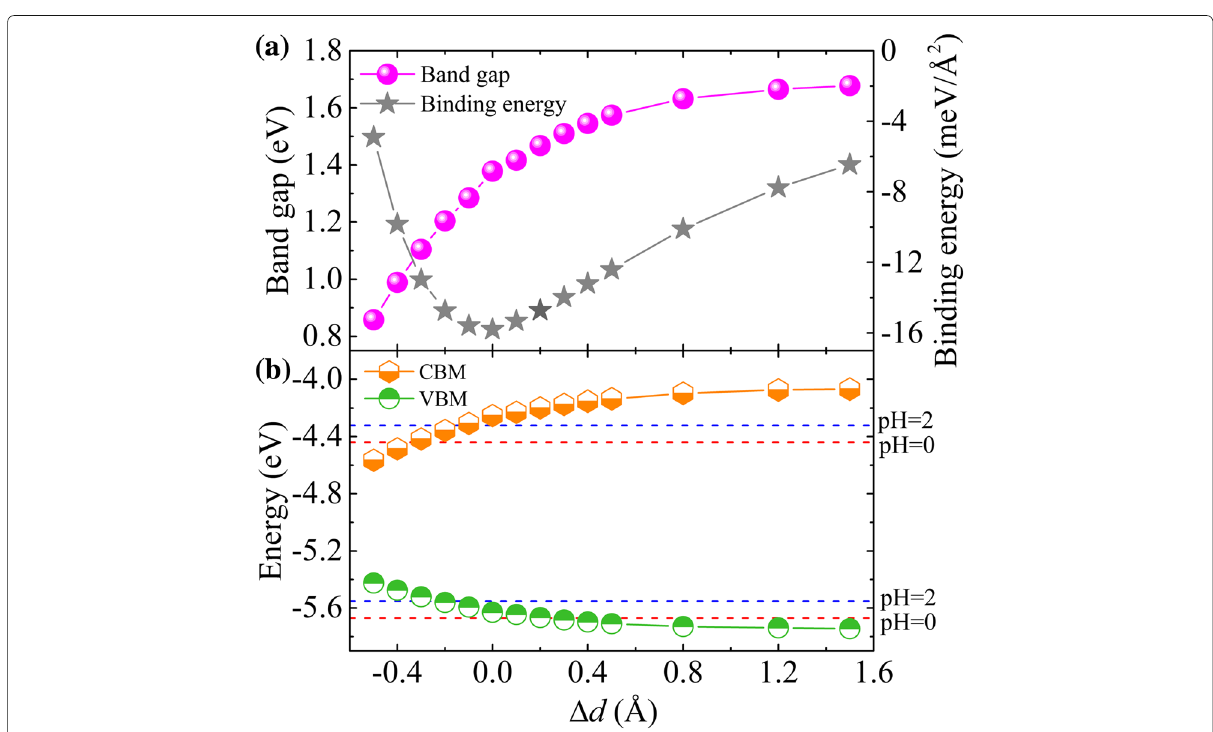
Fig. 4 Normal strain effects on a the bandgap and biding energy, and b the band-edge positions of GaTe/C 2 N vdW heterostructure. The redox potentials of water splitting at pH 0 (red dashed line) and pH 2 (blue dashed line) are shown for comparison